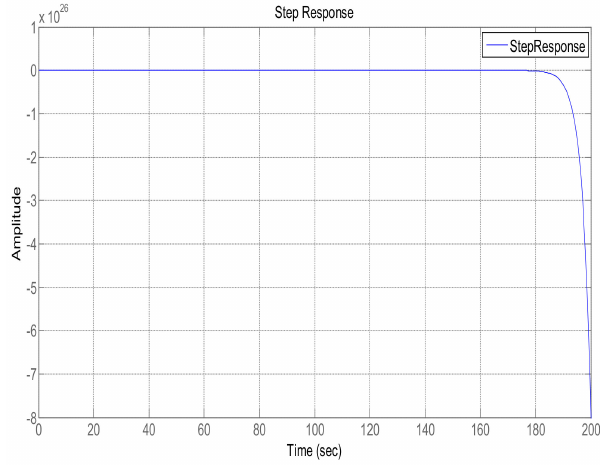
Figure 6. Step response of the system.